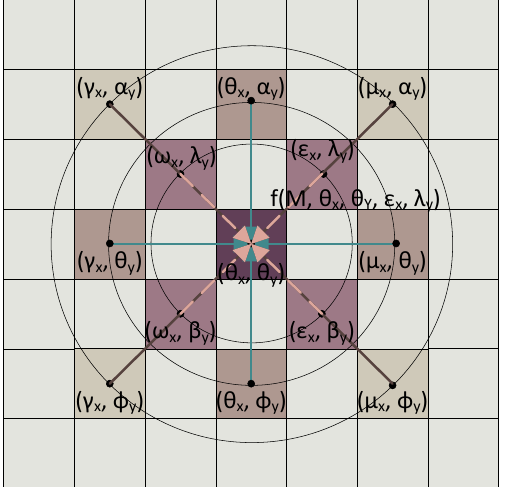
Figure 4. Structure of target alternating attention.